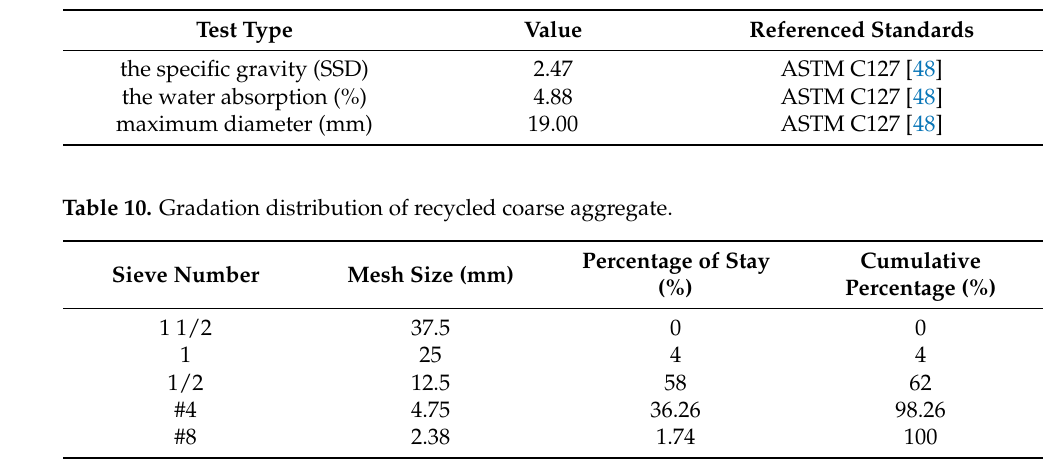
Table 9. Physical properties of recycled coarse aggregate.